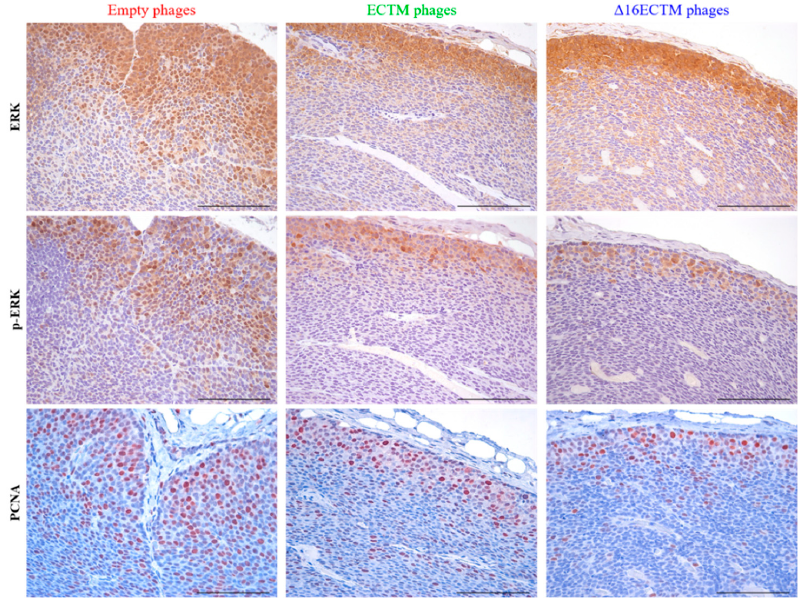
Figure 4. Ex vivo antitumor effects induced by phage-based vaccinations. Representative immuno- histochemical images of tumors (n = 3 tumors from 3 mice per group) excised at the end of the therapeutic experiment, stained with ERK, phospho-ERK and PCNA antibodies (brown cells). Scale bar 100 µm. Quantitative analysis of p-ERK+/ERK+ cells is shown in Supplementary Figure S2.